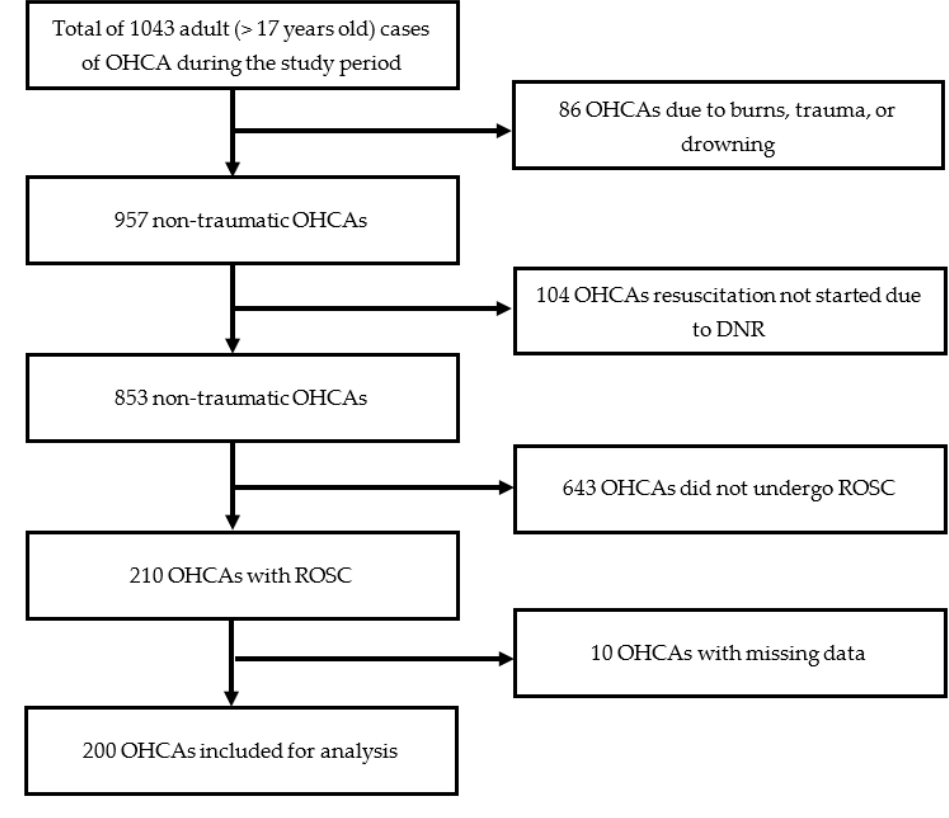
Figure 1. Flowchart of patients selection.